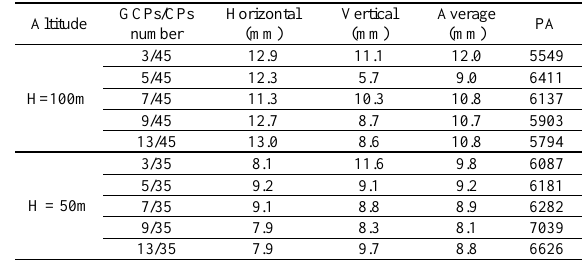
Table 10. Horizontal and vertical accuracy